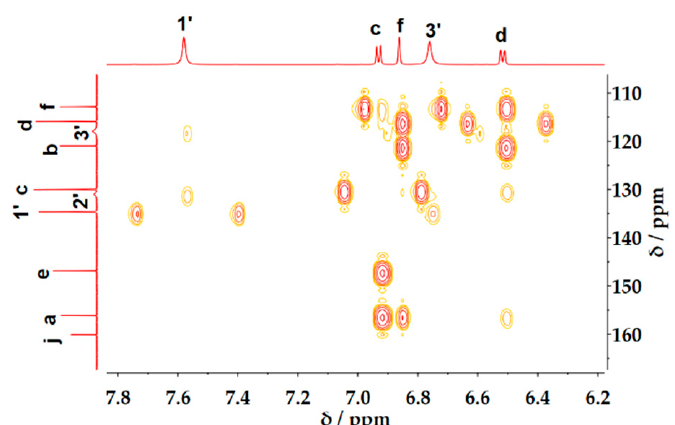
Figure 7. The 1 H– 13 C HMBC spectrum of [Et 4 N] [Car]:4CH 3 -Im (1:2) + CO 2 . Letters from a to f are the labels of hydrogen or carbon atoms of Car-based carbonate. Letter j is the label of carbonyl carbon of Car-based carbonate. Numbers 1’, 2’ and 3’ are the labels of hydrogen or carbon atoms of 4CH 3 -Im.